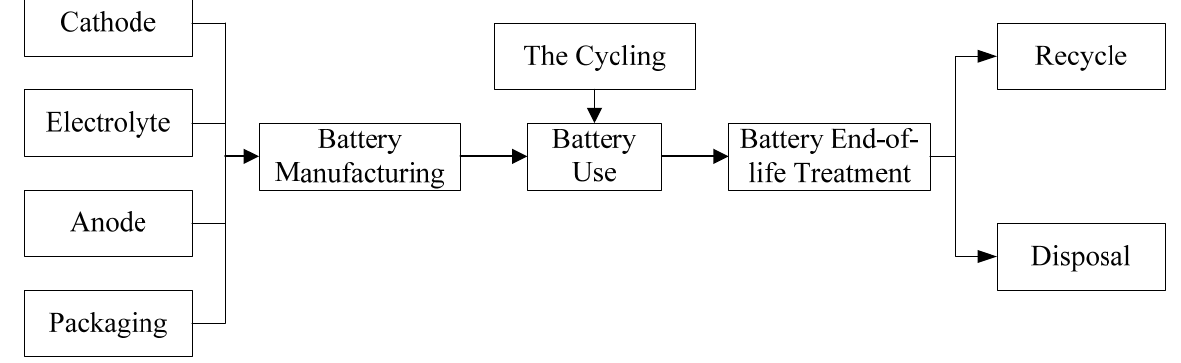
Figure 1. Flow diagram of the battery